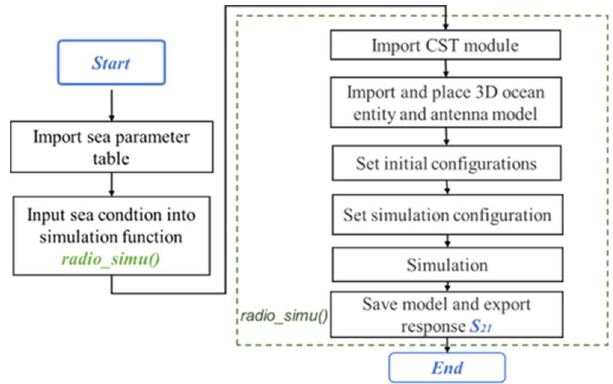
Figure 10. The diagram for automatic batch simulations. Sea parameters including ship distance D , antenna heights H R and H T , and wind speed U are input parameters, and the response will be exported to a table automatically.